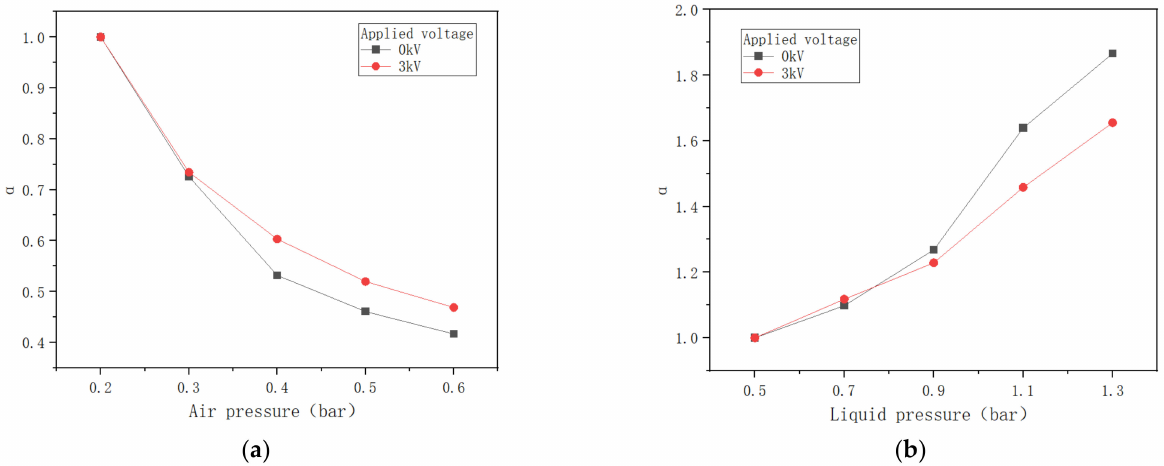
Figure 6. Trend of the VMD’s change ratio with pressure. ( a ) Liquid pressure of 0.9 bar, ( b ) Air pressure of 0.3